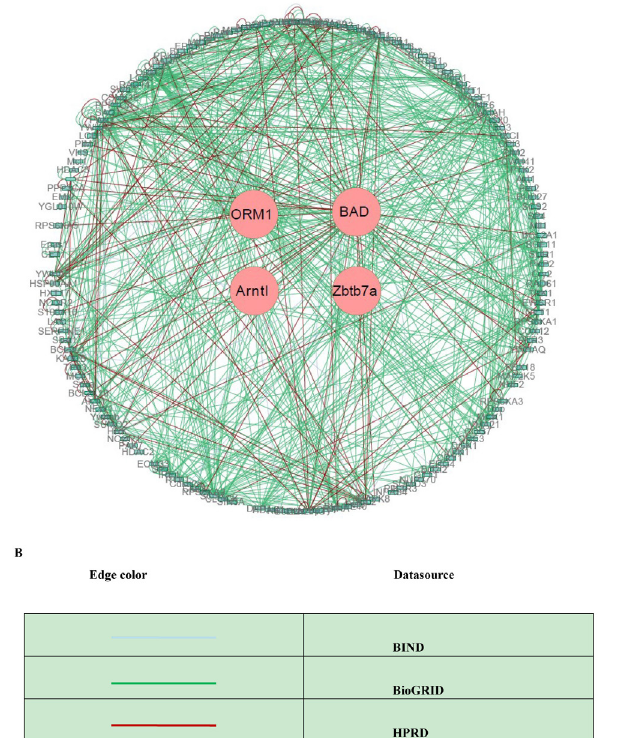
FIGURE 2 - Network of upregulated shared genes. (A) Network of upregulated shared genes based on Cytoscape v 3.5.1 software; (B) Red circular nodes in the center of network represent upregulated genes common to hypertension, diabetes and hyperlipidemia. The outer ring was constructed by green rectangular nodes of first neighbor genes of those in